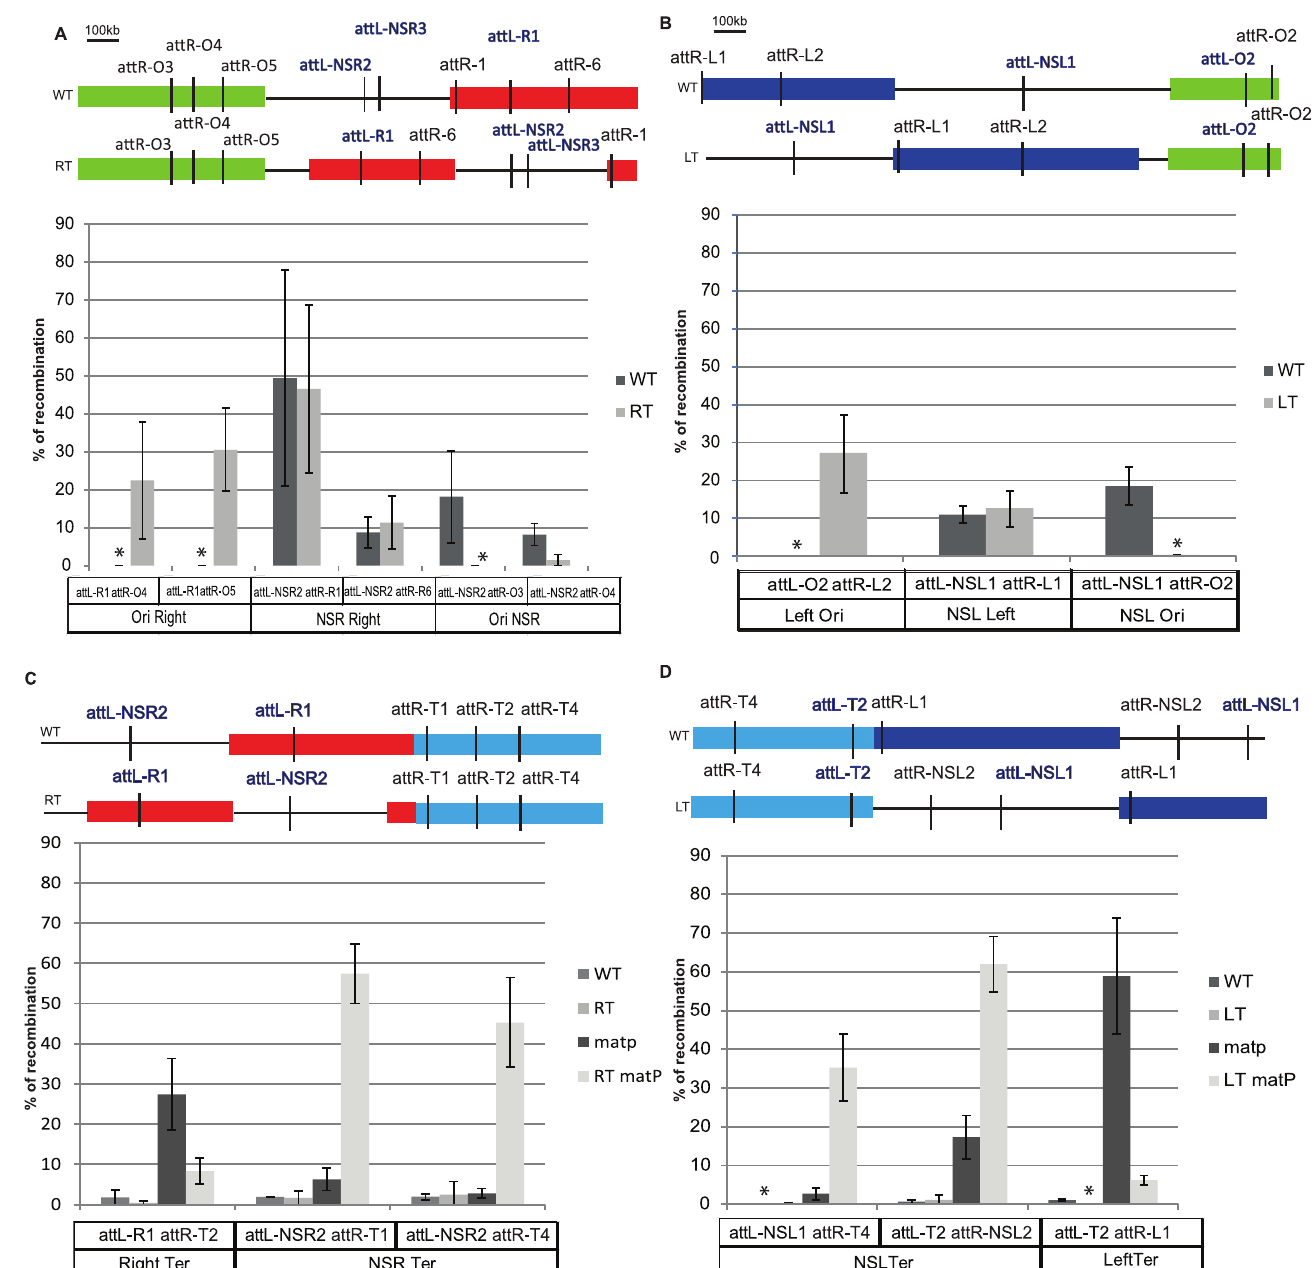
Fig 2. Effect of Right and Left transposition on long distance DNA interactions. Histograms of recombination frequency between attL and attR sequencesin WT, RT, and LT strains. The y-axis indicatesthe percentage of recombination between attL and attR sequences, obtainedas described in Materials and Methods with 20’ inductionat 36˚C. The relative positionof each att sequenceused in the experiment is representedon the MD map on top of each panel. Histogramsshow the averageof at least 3 independentexperiments with their respective standard-deviation. Frequencies obtainedin the WT strain are representedwith the black bars, in the RT strain (A,C) or LT strain (B,D) with the gray bars and in the Δ matP RT strain (C), or Δ matP LT strain (D) with the light gray bars. * indicatesthat no att L -att Rrecombinant was obtained. MDs to interact with each other in a Δ matP mutant. In the WT strain, chromosomal loci from the Right MD are not able to interact with chromosomal loci from the Ori MD as shown in S1 Fig: an attR-R4 sequence inserted in the middle of the Right MD interacts with an attL